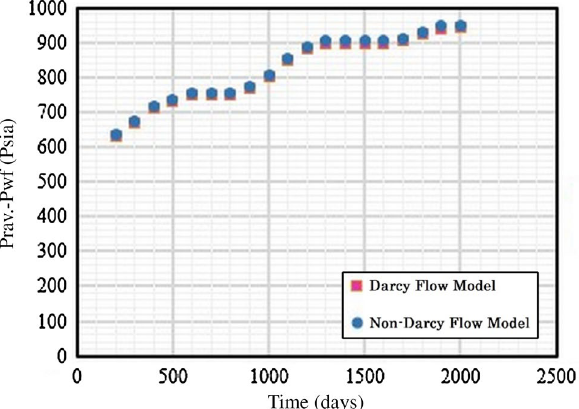
Fig. 13 Comparison of the Darcy with the non-Darcy flow